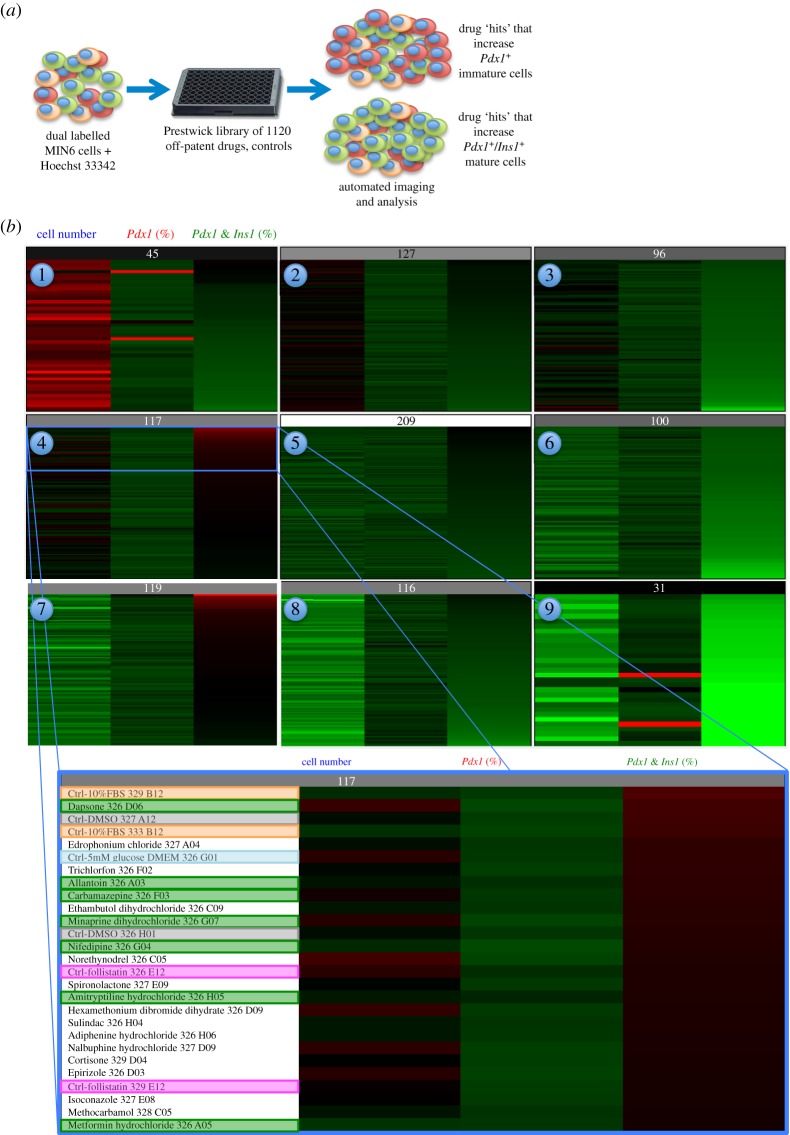
Self-organizing response groupings of a three-parameter high-content screen to assay Ins1 promoter activity, Pdx1 promoter activity and cell proliferation/survival. (a) Experimental design for a three-parameter, high-throughput imaging screen using MIN6 β-cells. (b) Self-organizing heat maps of nine result groups generated with AcuityXpress software. In these heat maps, red represents high and green represents low. Screen hits were chosen based on their clustering with positive controls. For example, follistatin is a positive control for a factor that increases Ins1 promoter activity and β-cell differentiation. The blow-up of group 4 (bottom panel) contains the hits that were followed up in this study.